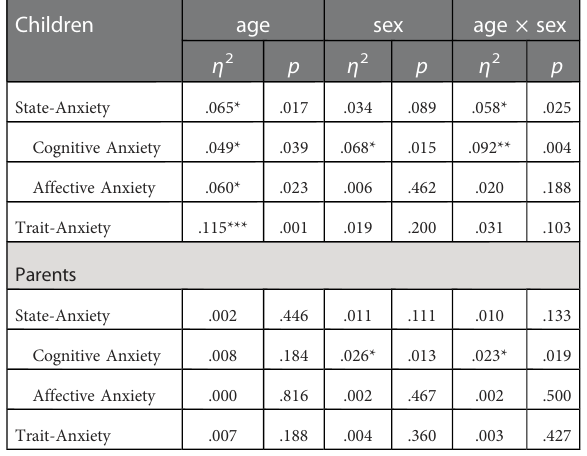
TABLE 4 Association between operative anxiety measured by the STOA and